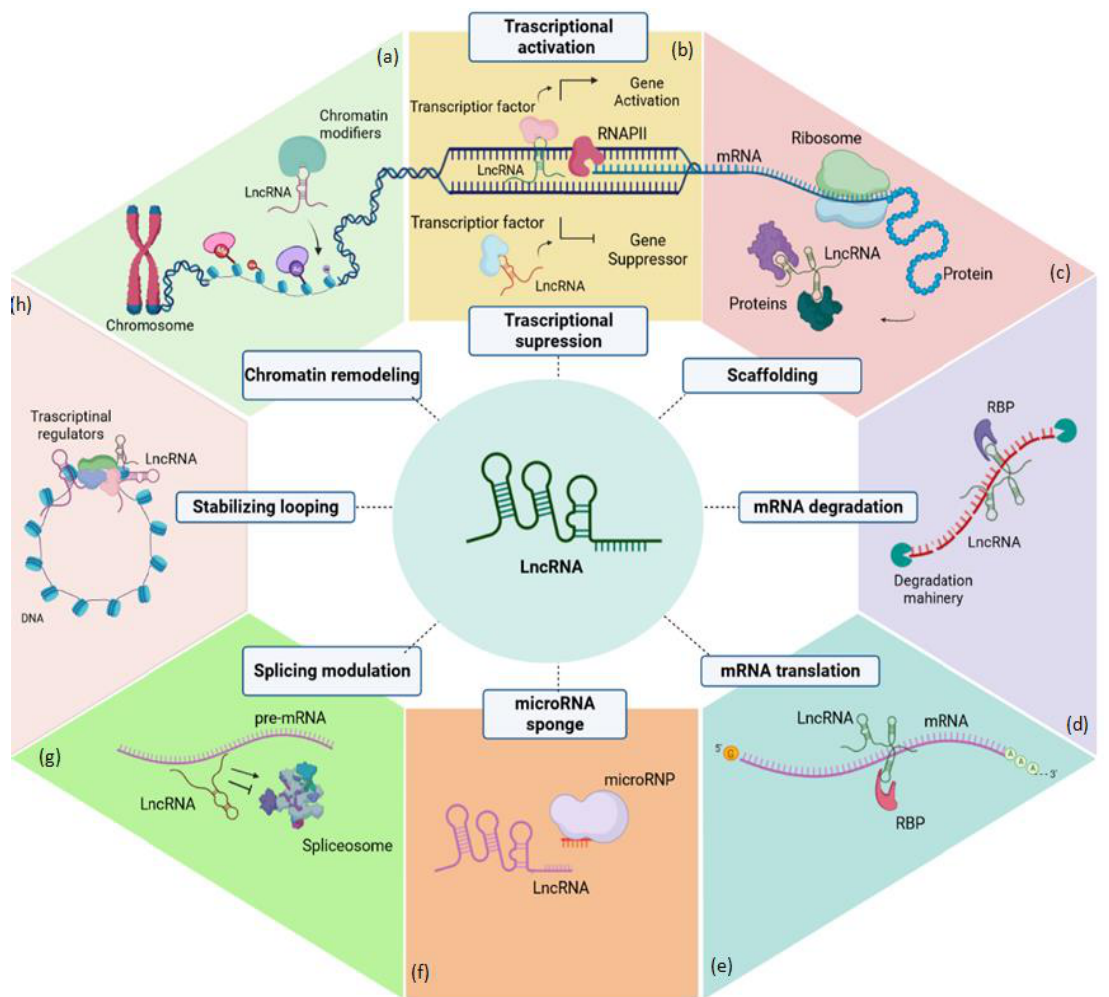
Figure 1. Classification of lncRNA functions. LncRNAs act as regulators of gene expression: ( a , h ) they can influence chromatin architecture by interacting with different protein components of the remodeling complex and modifying chromatin organizational patterns. ( b ) They activate the transcription of certain genes by driving transcription factors to their promoters and by targeting transcriptional modulators such as RNA polymerase (RNAP) II; ( c ) however, they are also capable of suppressing transcription by sequestering transcription factors and keeping them away from their promoters. LncRNAs also control various aspects of post-transcriptional mRNA processing, including: ( d ) they perform scaffolding roles by providing docking sites for proteins that function together in the same biological pathway; ( e ) through binding to protein interactors, including classical RNA-binding proteins (RBPs), they are able to modulate mRNA functioning by also subjecting them to degradative pathways; ( f ) they act like “ sponges ” by base pairing with their complementary miRNAs and reducing their effects; ( g ) they alter their splicing patterns.